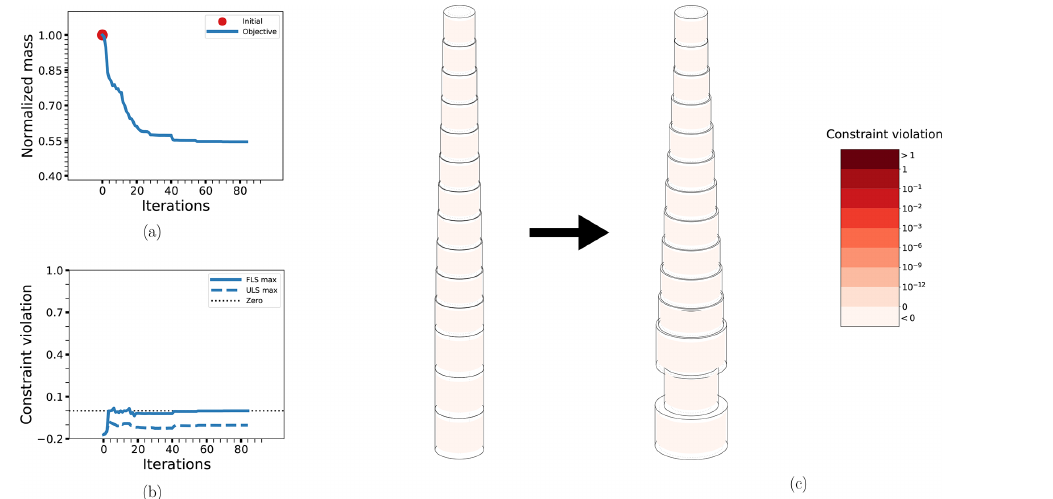
Figure 11. The optimization process for case OC3-DA: the objective function (a) , maximum non-linear constraint violations (b) and the change in the design from initial to final configuration (c) . Details as in previous